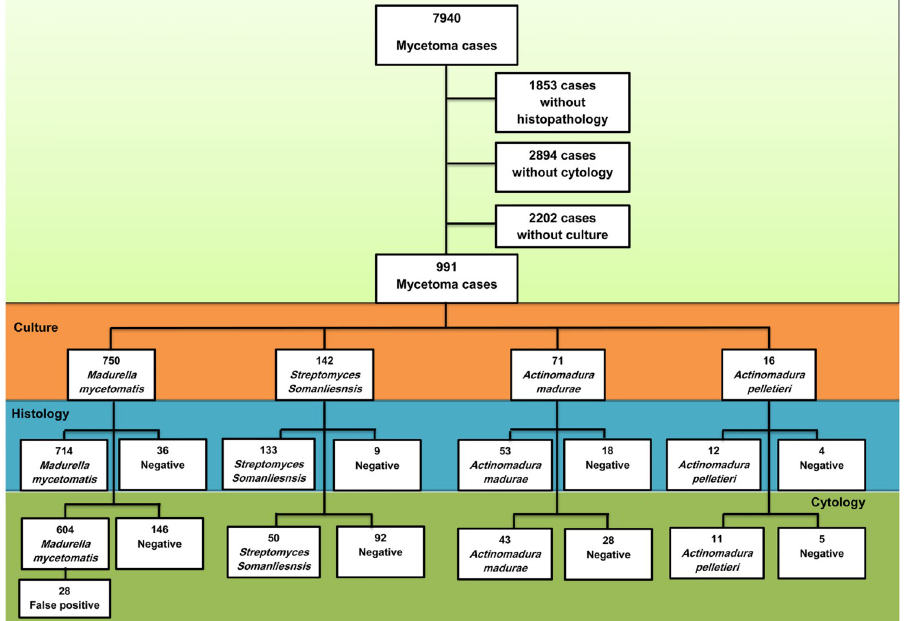
Fig 1. identification of the causative agents: All culture, histopathological and cytological identification reports of patients seen between January 1991 and January 2018 in the Mycetoma Research Centre were retrieved from our electronic database. Of these patients in 2202 cases no microbiological report was available, of 1853 cases no histopathological report was available and in 2894 cases no cytological report was available leaving 991 mycetoma cases which met our inclusion criteria. The culture identification was considered the golden standard. Of these patients 750 cases were caused by M . mycetomatis , 142 cases by S . somaliensis , 71 were caused by A . madurae and 12 by A . pelletieri . From these cases the histological and cytological reports were compared to the culture results. A histological report or cytological report was either identical to the culture identification or negative. Results for both histology and